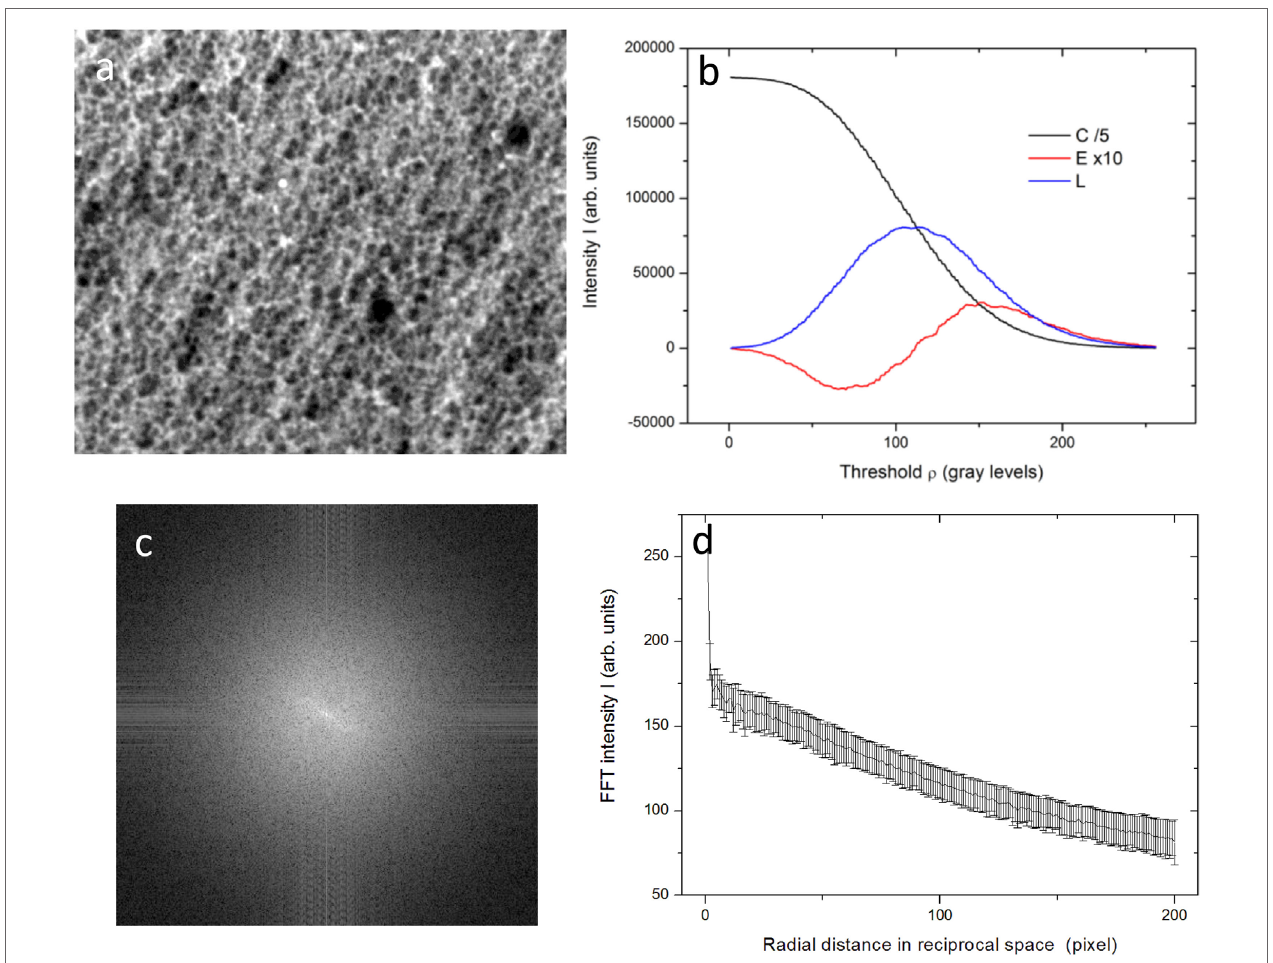
FigUre 1 | representative case (0°c, 8 V) for the type of samples and data involved in the analysis: (a) seM image, (B) Minkowski functionals, from which C flex , E min , and L max are extracted, (c) FFT map, (D) radially averaged profile of the FFT map, from which the Δ R and if possible R 0 and R are extracted [not in this case due to missing peak, for more details, see Toccafondi et al. (2014)] . FigUre 2 | set of anodizations carried out at 0°c: (a) regularity ratio spread and (B) Minkowski parameters plotted versus the anodization voltage .